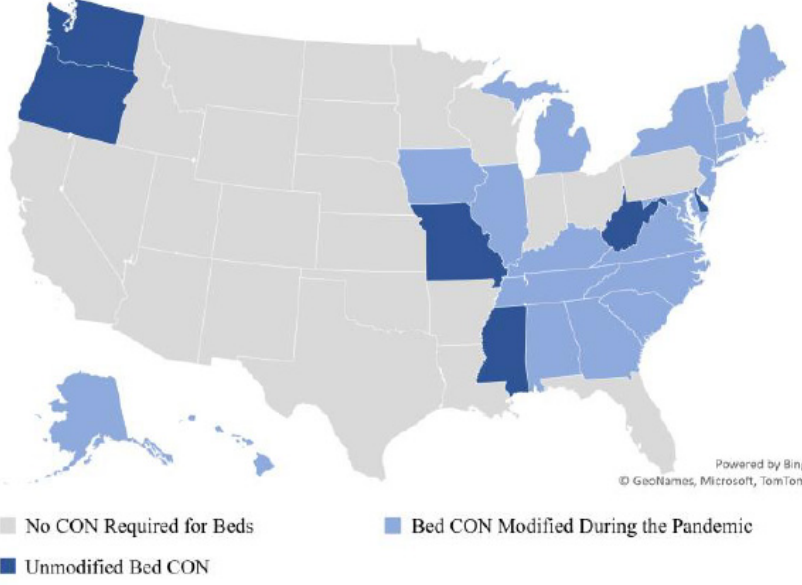
Figure 6. Bed CON Regulations during the Pandemic. Source: State CON regulators.